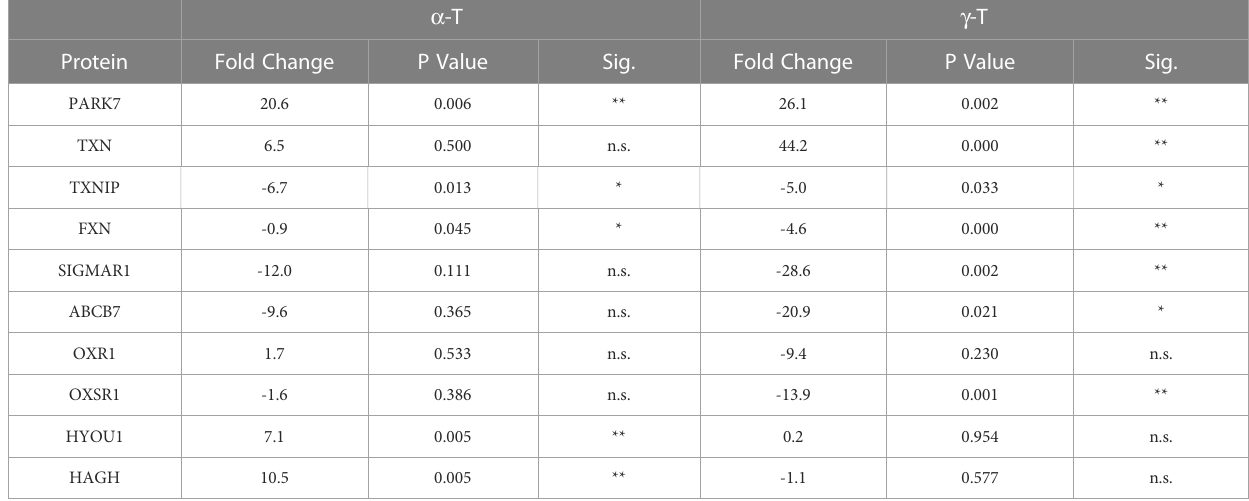
TABLE 6 The effect of a T and g T on the expression of proteins involved in the antioxidant response. a -T g -T Protein Fold Change P Value